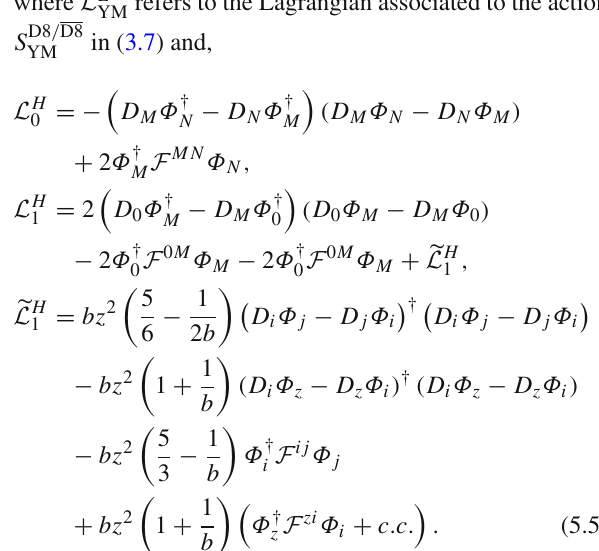
Fig. 2 Various brane configuration in the τ − U plane where τ is compactified on S 1 . The bubble background (cigar) is produced by N c D4-branes with N 0 smeared D0-branes. The N f = 3 light (chiral) D8 / D8-branes (L) at antipodal position of the cigar are represented by the blue line. A pair of heavy D8 / D8-brane (H) is separated from the light branes which is represented by the red line. The massive state is produced by the strings stretched between the light and heavy branes which is represented by the green line (i.e. the HL-string) in this figure. The baryon spectrum is produced by the baryon vertex which lives inside the